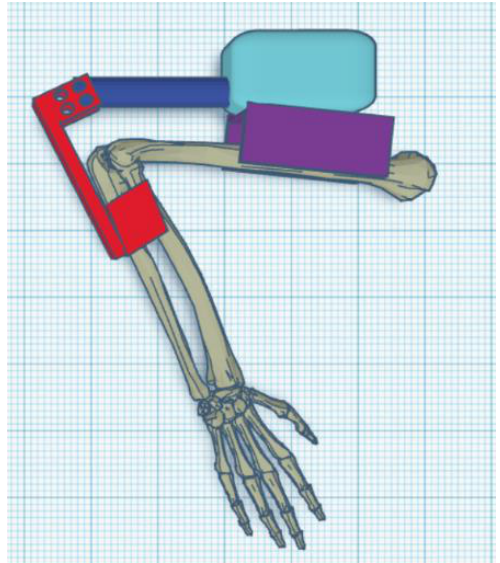
Figure 10. Flexed exoskeleton with arm (120 ◦ ).